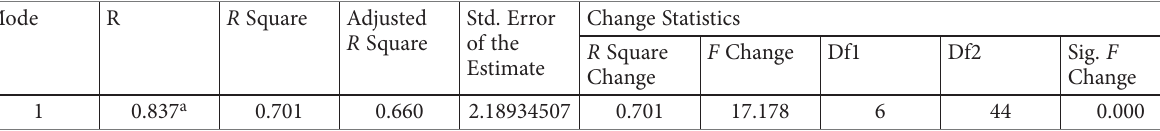
Table 7. Summary of regression model properties a